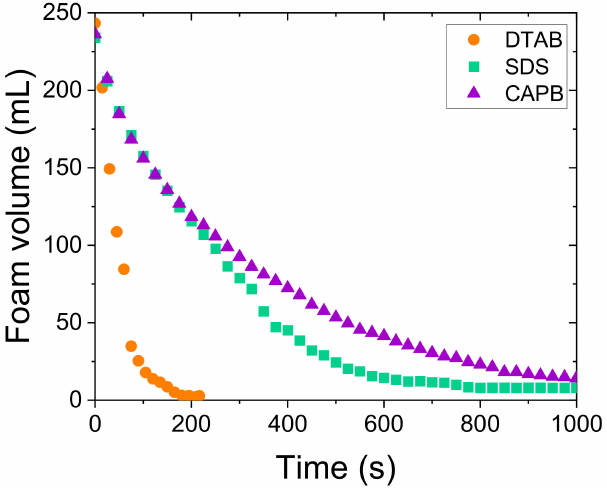
Figure 1. Foam decay profiles of CO 2 foam formed with 0.1 wt % surfactant-only formulations, in desulphated seawater brine at 25 ◦ C (standard deviation: foam height < 5 mL).